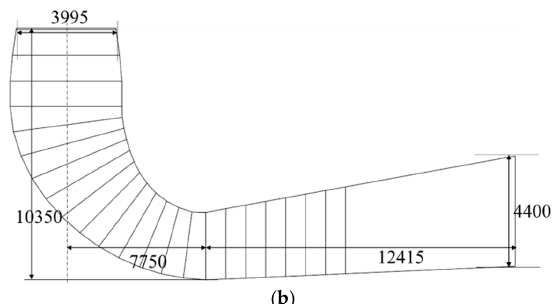
Figure 5. ( a ) Top view and ( b ) side view of draft tube (all dimensions are in mm).